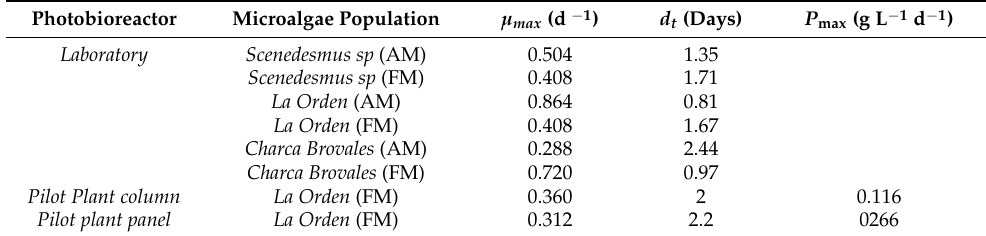
Figure 6. Growth curves of the different microalgae populations cultured in fertilizer medium. Table 2. Highest maximum specific growth rates ( µ max ) and lowest generation time ( d t ) and maximum productivity ( P max